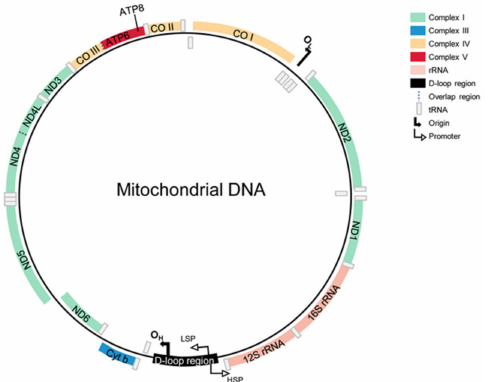
Figure 1. The structure of mtDNA. It encodes 2 rRNAs and 22 tRNAs for protein synthesis, as well as 13 peptides for electron transfer and oxidative phosphorylation. Except for these coding areas, mtDNA has a non-coding region located in the displacement (D)-loop, which participates in the regulation of mtDNA replication transcription. The genes coding for subunits of OXPHOS complex I are ND1-ND6. The gene encoding for cytochrome B of complex III is abbreviated as Cyt B. Genes